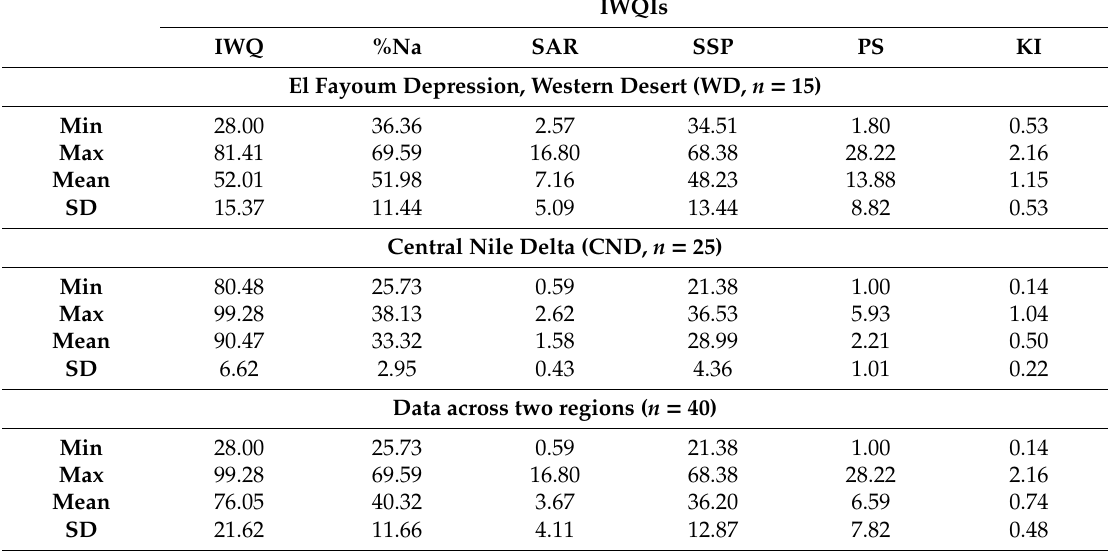
Table 4. Minimum (Min), maximum (Max), mean, and standard deviation (SD) of the di ff erent irrigation absorption ratio (SAR), soluble sodium percentage (SSP), potential salinity (PS), and Kelly’s index (KI) in the Western Desert and Central Nile